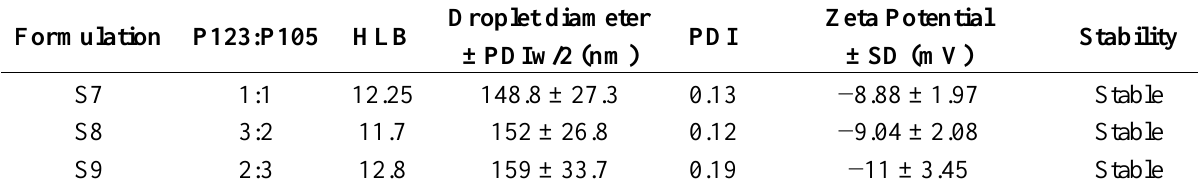
Table 2. Summary of formulations prepared with PFTE/olive oil (1:1) and Pluronic ® P123 and P105 as surfactants.